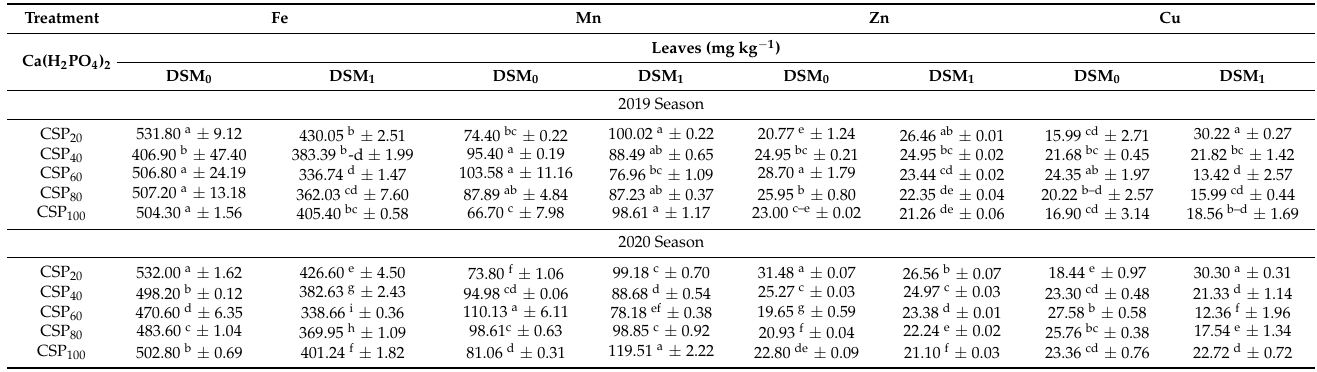
Table 5. Influence of interaction between phosphorus fertilizer and Bacillus megaterium DSM 2894 var. on some leaf micronutrients content of sweet potato plants grown on calcareous saline soil in 2019 and 2020 seasons.